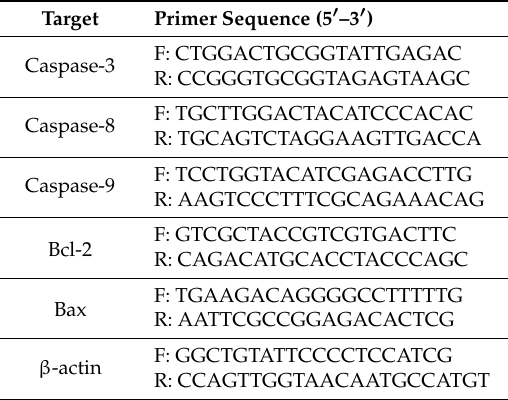
Table 2. Primers used for real-time quantitative